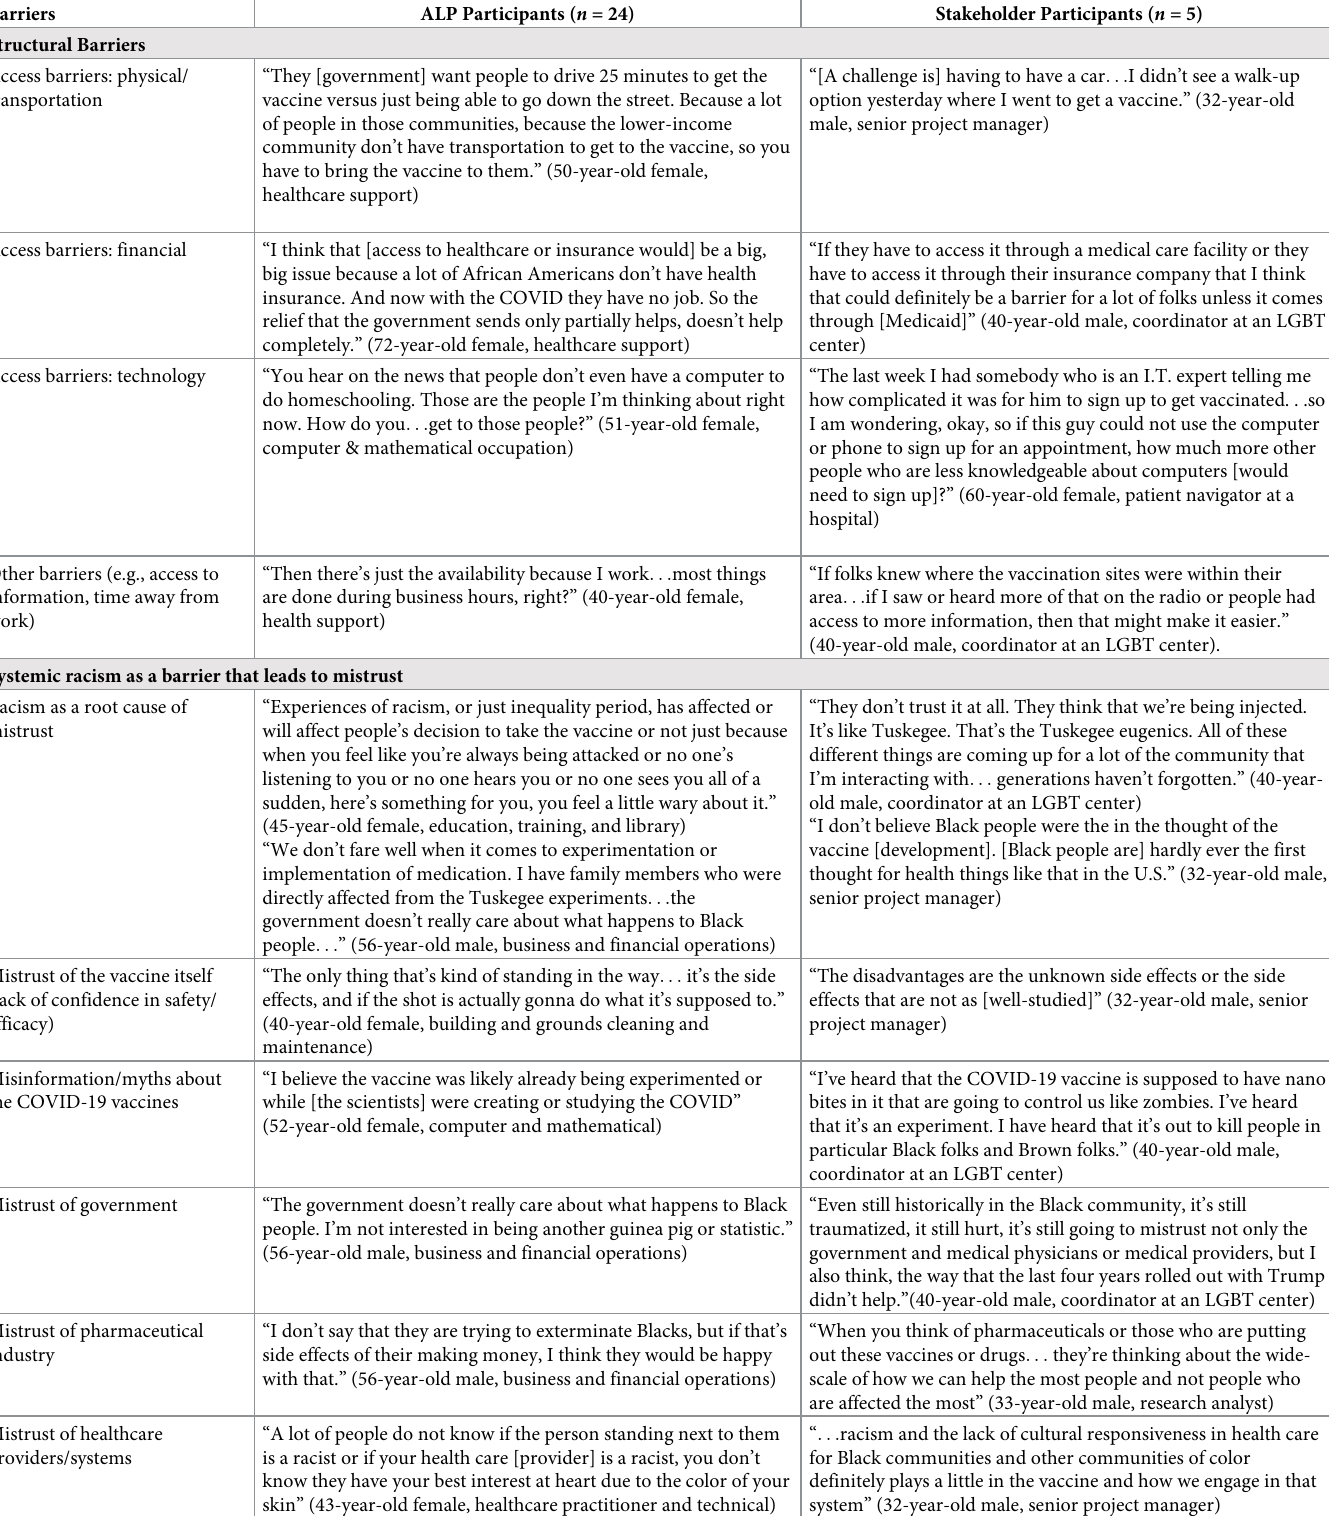
Table 3. Barriers to COVID-19 vaccination from semi-structured interviews ( n =